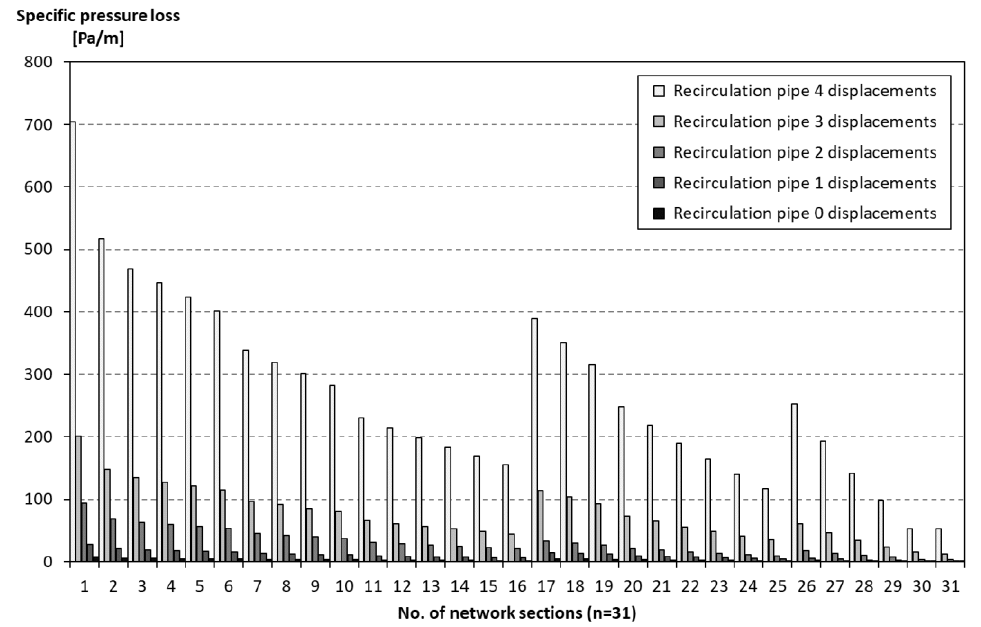
Figure 7. Specific pressure drops [Pa/m] for five different sizes of the recirculation pipe along the sections of the longest route in the assessed distribution network during design conditions (summer night) with different series for each respective displacement level of the third pipe (0 –